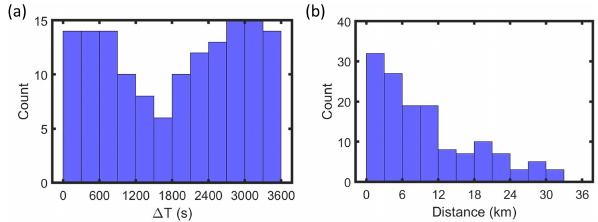
Figure 2. Histograms of (a) the time gap between a cloud profile and the co-located MODIS scan ( (cid:49)T ) and (b) the distance between a cloud profile and the co-located MODIS pixel after adjusting for